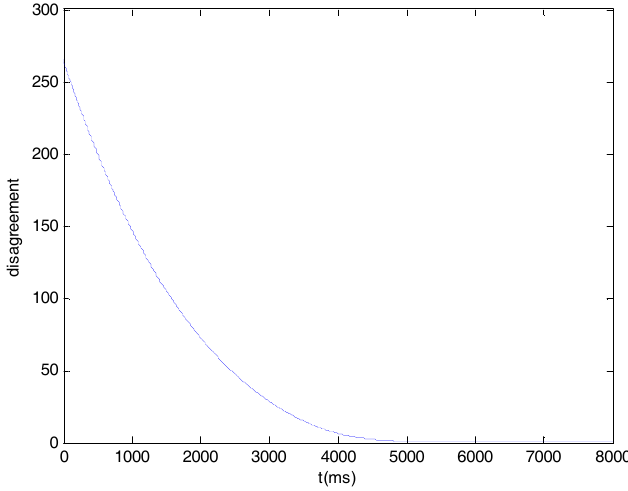
2 . Figure 6. State trajectories and the disagreement function (cid:107) δ (cid:107) 2